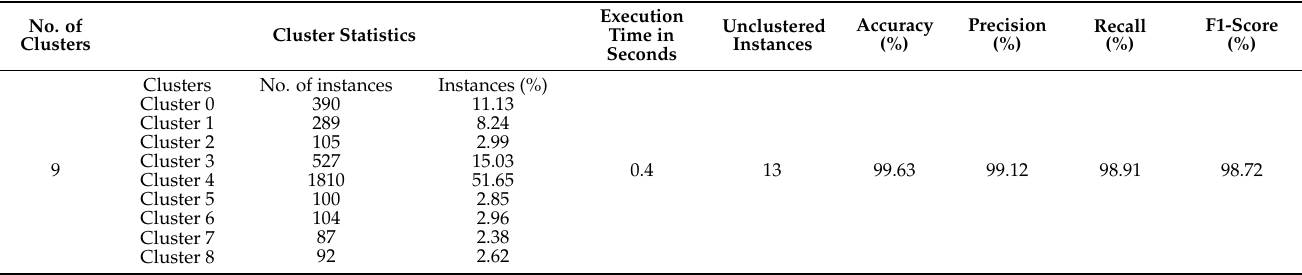
Table 5. Algorithm performance factors for Lab Test